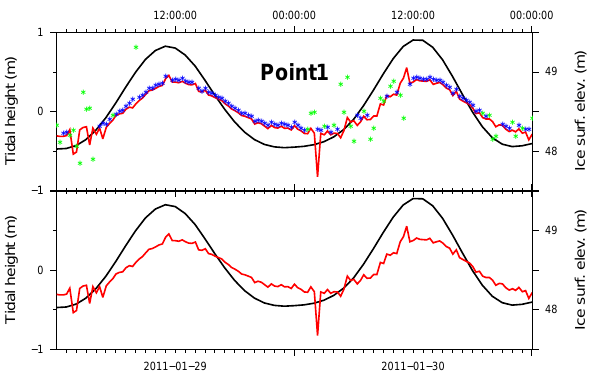
Figure 13. Time-dependent surface displacements during two days in January 2011 at point 1. The bottom panel shows the tidal signal (black) and the vertical ice upper surface displacements obtained in Real Time Kinematic (RTK) differential mode (red). GPS data were also post-processed so as to confirm the validity of the RTK method. Corresponding results are depicted as blue stars (upper panel) when ambiguities were fixed and as green stars otherwise. The consis- tency between the red curve and the set of blue stars confirms the validity of the RTK approach whose results are then later systemat- ically used in Fig. 14.